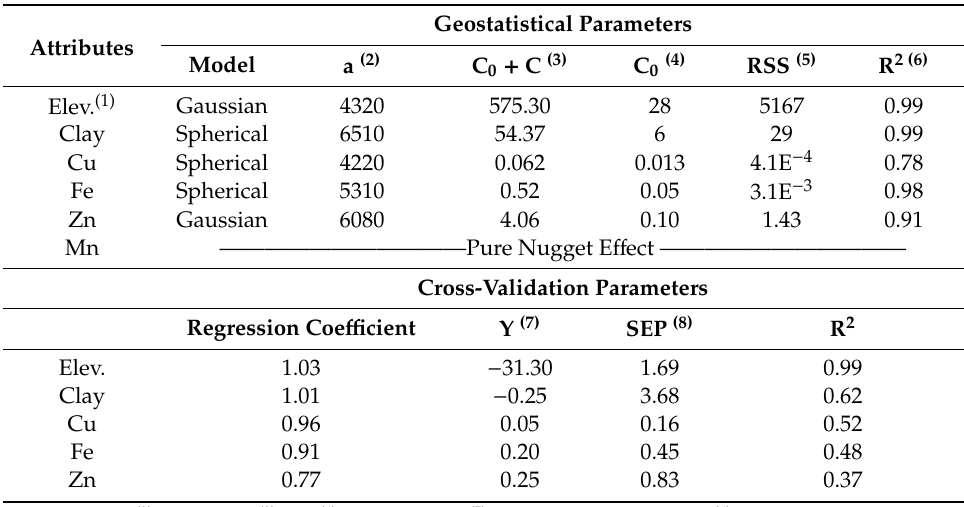
Table 2. Theoretical semivariogram parameters and cross-validation analysis for modelling the spatial dependence of the elevation and soil attribute.